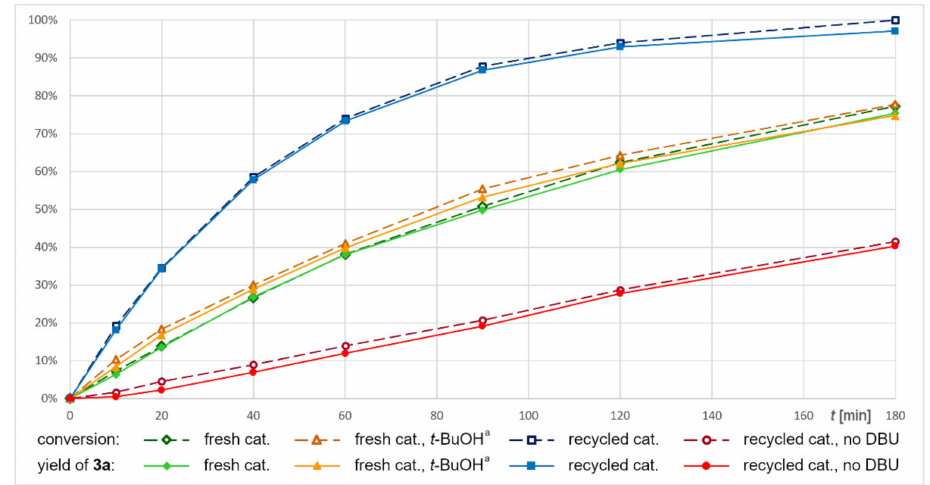
Figure 3. Comparison of the activity of fresh and 6 times recycled G 1 (DippImI) 4 (2.5 mol%) in the redox esterification of cinnamaldehyde (4 equiv of benzyl alcohol, toluene, 100 ◦ C; 10% DBU unless otherwise noted). a 2 equiv of benzyl alcohol were replaced by tert -butyl alcohol. Table 4. Recycling of G 1 (DippImI) 4 in redox esterification of cinnamaldehyde with benzyl alcohol a .